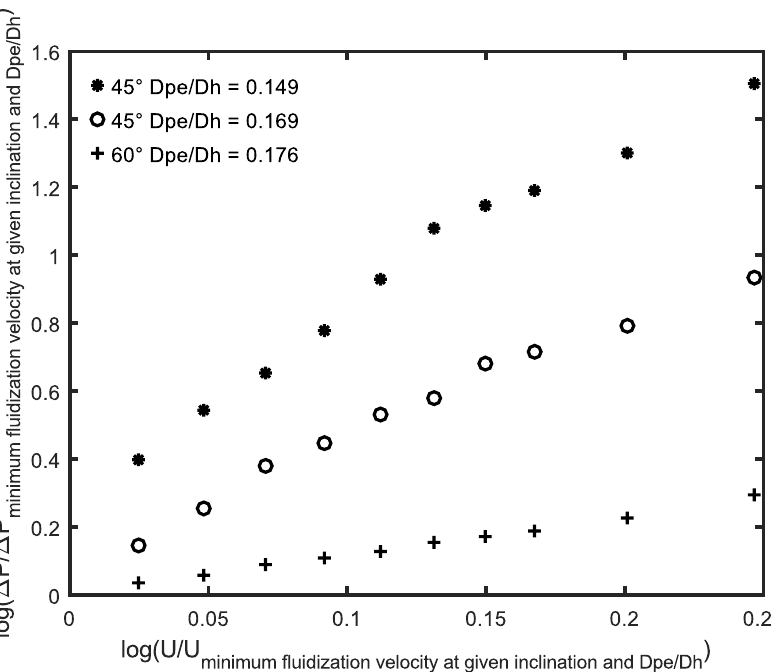
Figure 9. Relative pressure drop as a function of relative superficial velocity under two inclinations and three hydraulic diameters for particle P# 5.